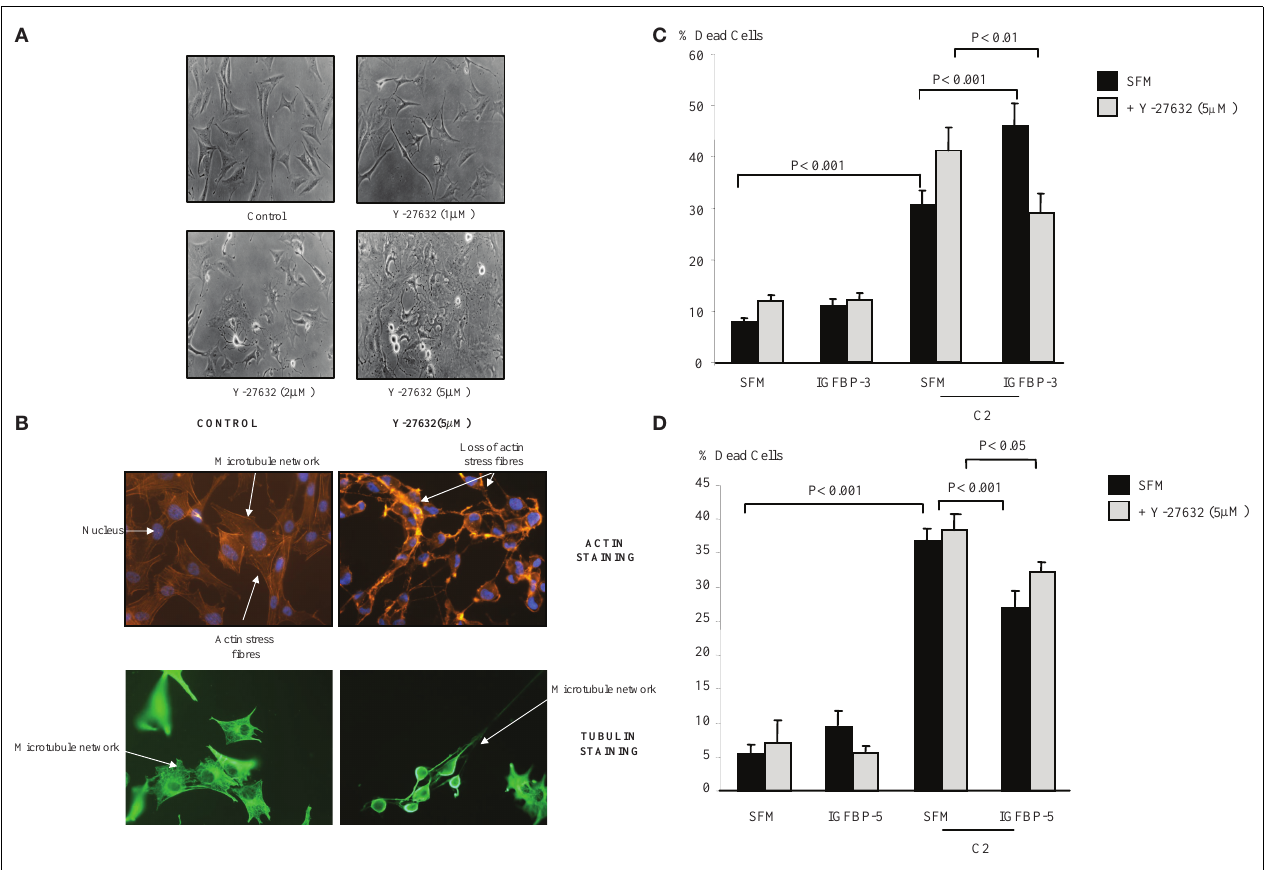
Methods.” Hs578T cells were seeded in six-well plates at 0.1 × 10 6 cells in GM followed by 24h in SFM prior to pre-dosing with (C) IGFBP-3 (100ng/ml) or (D) IGFBP-5 ± Y-27632 (5 μ M).The cells were then re-dosed with IGFBP-3 or IGFBP-5 (each at 100ng/ml) for a further 24h in the presence or absence of an apoptotic dose of C2-ceramide.The graphs represent changes in cell death and show the mean ± SEM of three experiments each repeated in